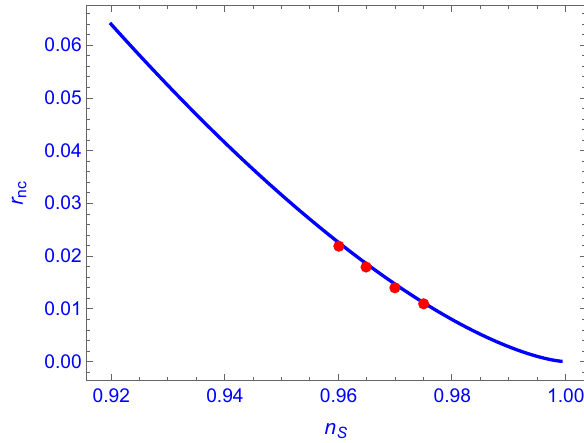
Fig. 2 The n s − r nc diagram for the anisotropic power-law inflation found in this paper with g 0 ∗ = − 0 . 03 and 10 − 2 ≤ c s ≤ 10 − 1 . Four red points have the corresponding values such as ( n s , r nc ) (cid:8) ( 0 . 96 , 0 . 022 ) for c s (cid:8) 0 . 07, ( 0 . 965 , 0 . 018 ) for c s (cid:8) 0 . 066, ( 0 . 97 , 0 . 014 ) for c s (cid:8) 0 . 06, and ( 0 . 975 , 0 . 011 ) for c s (cid:8) 0 .